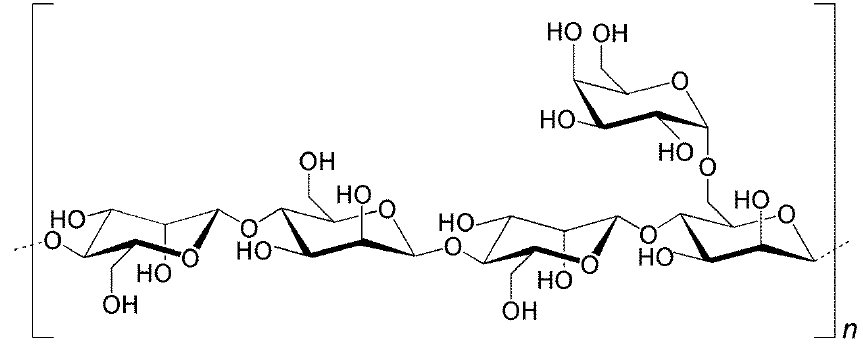
Figure 1. Structure of locust bean gum showing a linear polysaccharide (1–4)- β -linked backbone of mannose units with single (1–6)- α - D -galactose units attached.